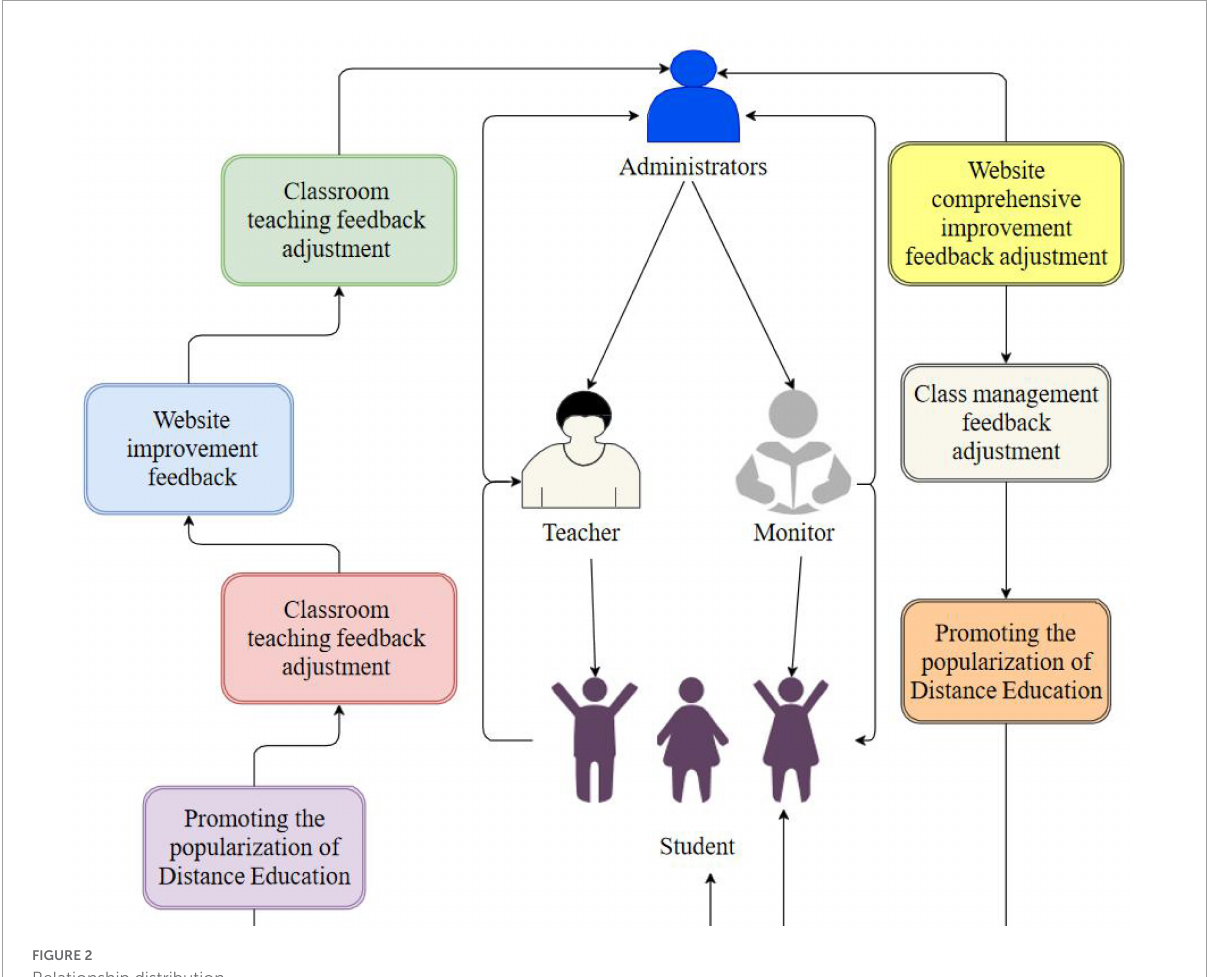
FIGURE2 Relationship